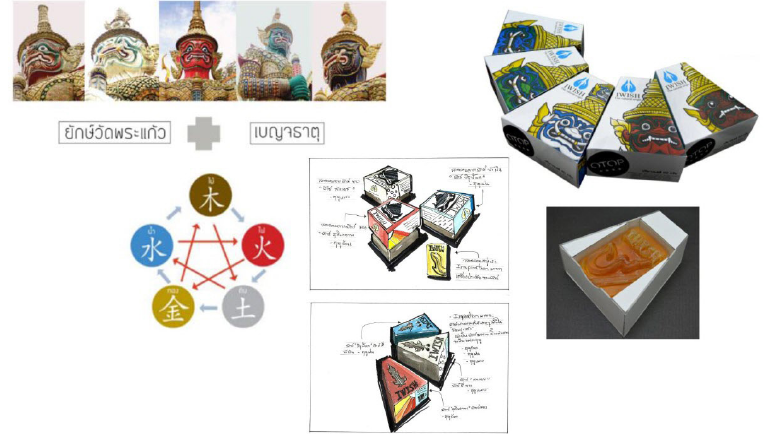
Figure 5. Group 5 design work inspired by giant sculptures at Wat Phra Kaew (source: created by